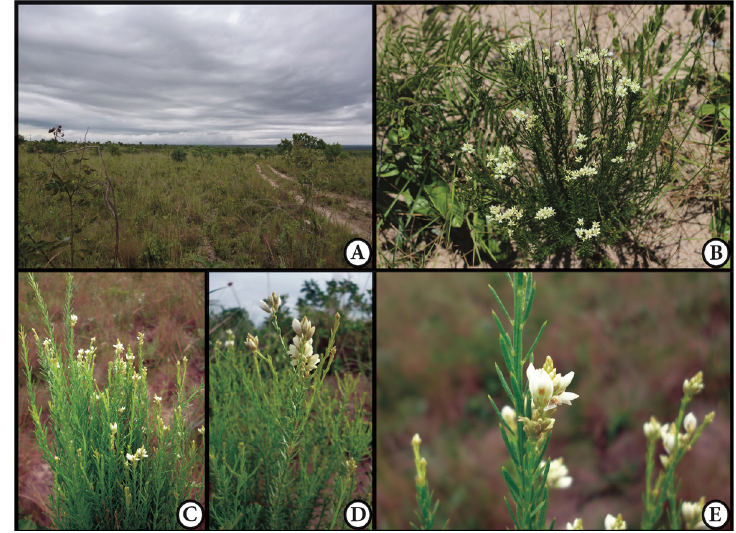
Fig. 2. Polygala bringelii J.F.B.Pastore & Antar sp. nov. A . Habitat. B . Habit. C–D . Flowering branches. E . Inflorescence detail. Photos: G.M. Antar, in situ.